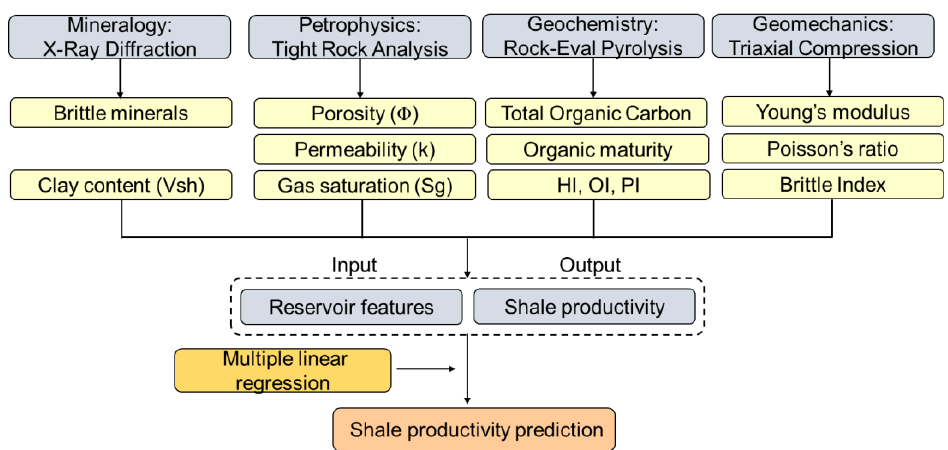
Figure 3. Sketch diagram of shale productivity evaluation in unconventional shale reservoirs.